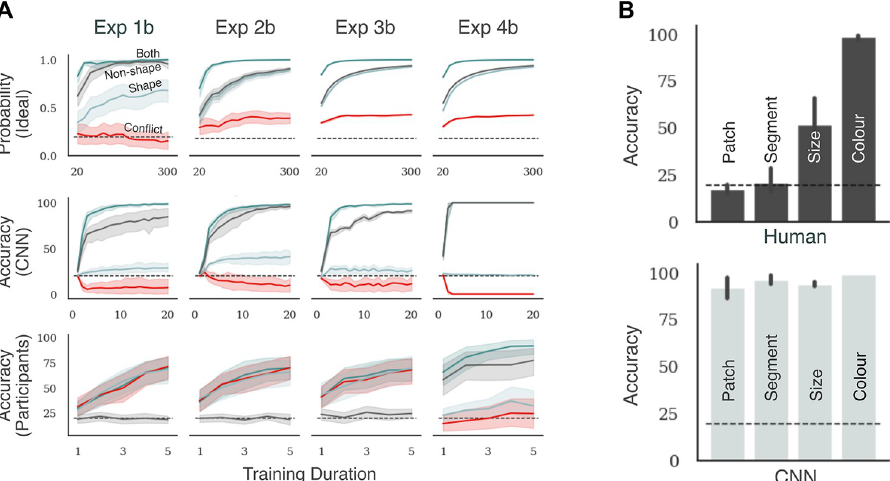
Fig 5. Each plot in Panel A shows how accuracy on the four types of test trials changes with experience. The top, middle and bottom row correspond to ideal inference model, CNN and human participants respectively. Columns correspond to different experiments. The scale on the x-axis represents the number of training trials in the top row, the number of training epochs in the middle row and the index of the test block in the bottom row. The two plots in Panel B show accuracy in test blocks for humans and CNN, respectively, when they are trained on images that lack any coherent shape. Each bar corresponds to the type of non-shape feature used in training.